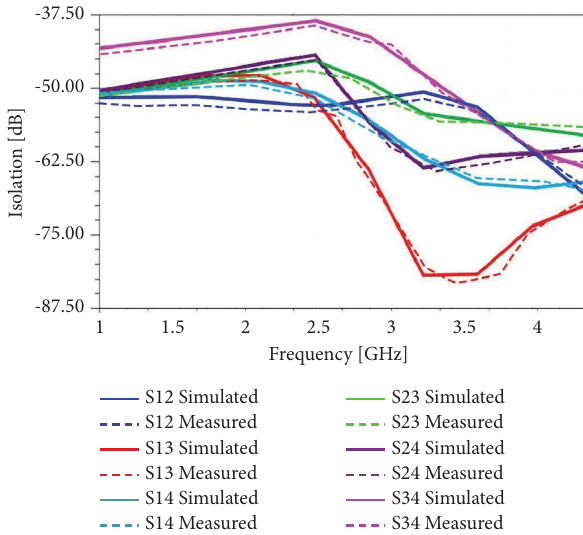
Figure 19: Simulated and measured isolation response of 1 × 4 MIMO